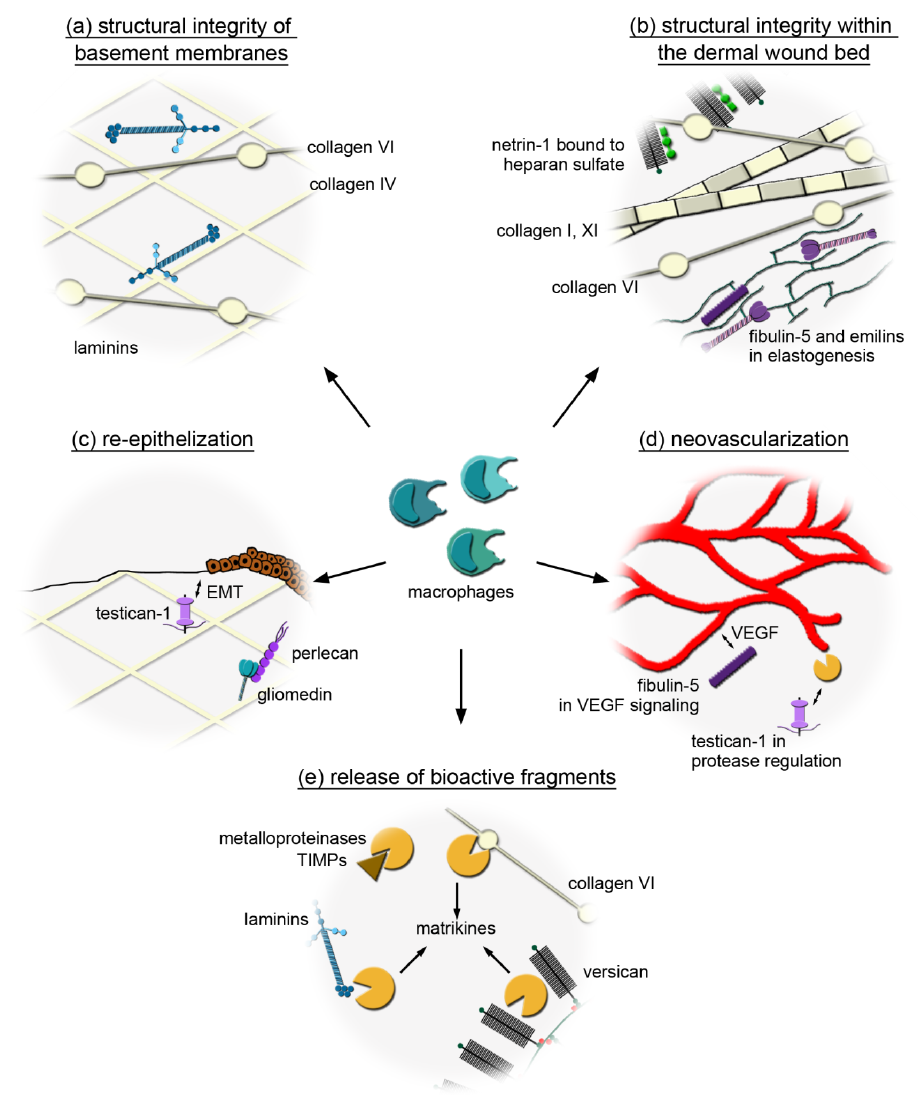
Figure 6. Potential wound healing mechanisms involving the macrophage-derived extracellular matrix (ECM). ( a ) Macrophages could produce collagen IV, VI and laminins to provide their own substrate and / or bridging proteins for their adhesion to basement memranes. ( b ) Macrophages may promote the formation of a microfibrillar network within the wound by producing the beaded filament forming collagen VI. Collagen XI may be utilized by macrophages to interact with fibrillar collagens and support their organization while macrophage-derived netrin-1 may provide guidance signals to organize the wound. Macrophages may secrete fibulin-5 and EMILINs to act as a sca ff old protein that organize and link elastic fibres. ( c ) Macrophage-derived gliomedin that binds to perlecan might participate in basement membrane formation / stabilization and influence keratinocytes to regulate epithelial wound closure. By producing testican-1, which is a target of TGF- β and induces epithelial-to-mesenchymal transition (EMT), macrophages may support epithelial wound closure. ( d ) Macrophage-derived testican-1 may also regulate metalloproteinase activity to promote the degradation of provisional wound matrix supporting vascularization, while fibulin-5 synthetized by macrophages may regulate angiogenesis by modulating VEGF signaling. ( e ) Macrophages may express proteases (A disintegrin and metalloproteinase with thrombospondin motifs (ADAMTS2), MMP9, MMP1) and their inhibitors (TIMP1–3) to generate bioactive ECM fragments (matrikines) and may also be a source of ECM molecules that harbor these bioactive fragments (collagen VI, laminins,